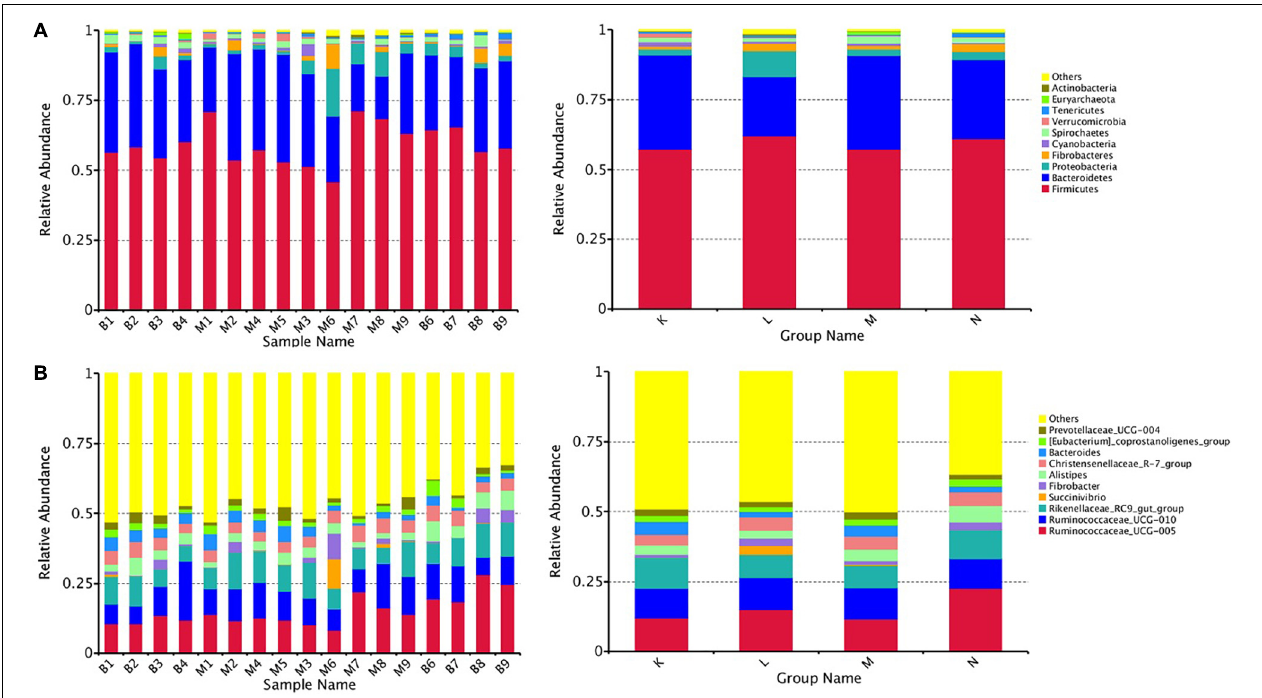
FIGURE 2 | Fecal microbial composition of European mouflon and blue sheep at the phylum (A) and genus (B) levels. K, low-altitude mouflon; L, high-altitude mouflon; M, low-altitude blue sheep; N, high-altitude blue